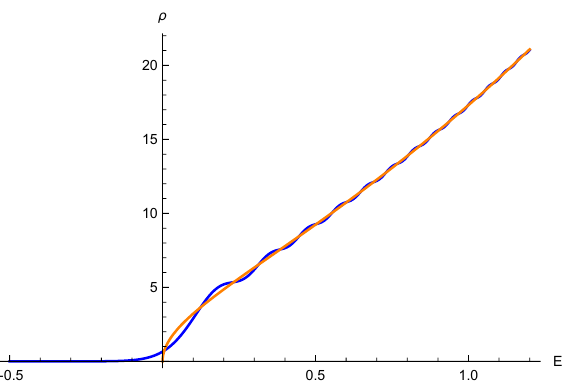
Figure 1 . Plot of (cid:26) ( E ) for ~ = 1 = 30. The blue curve represents (cid:26) ( E ) in the approximation (4.2) while the orange curve represents the genus-zero eigenvalue density (cid:26) 0 ( E ) in